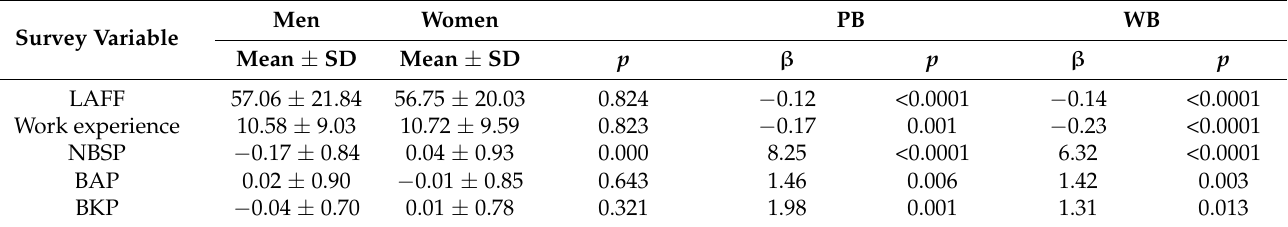
Table 3. Association of survey variables with